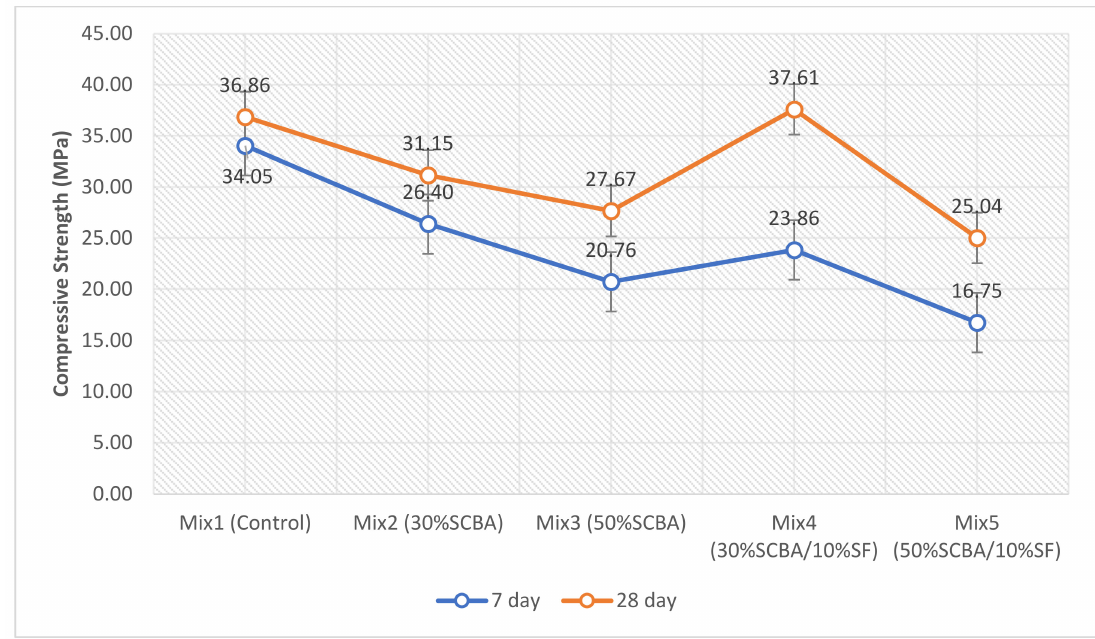
Figure 8. Compressive Strength results at curing ages of 7 and 28